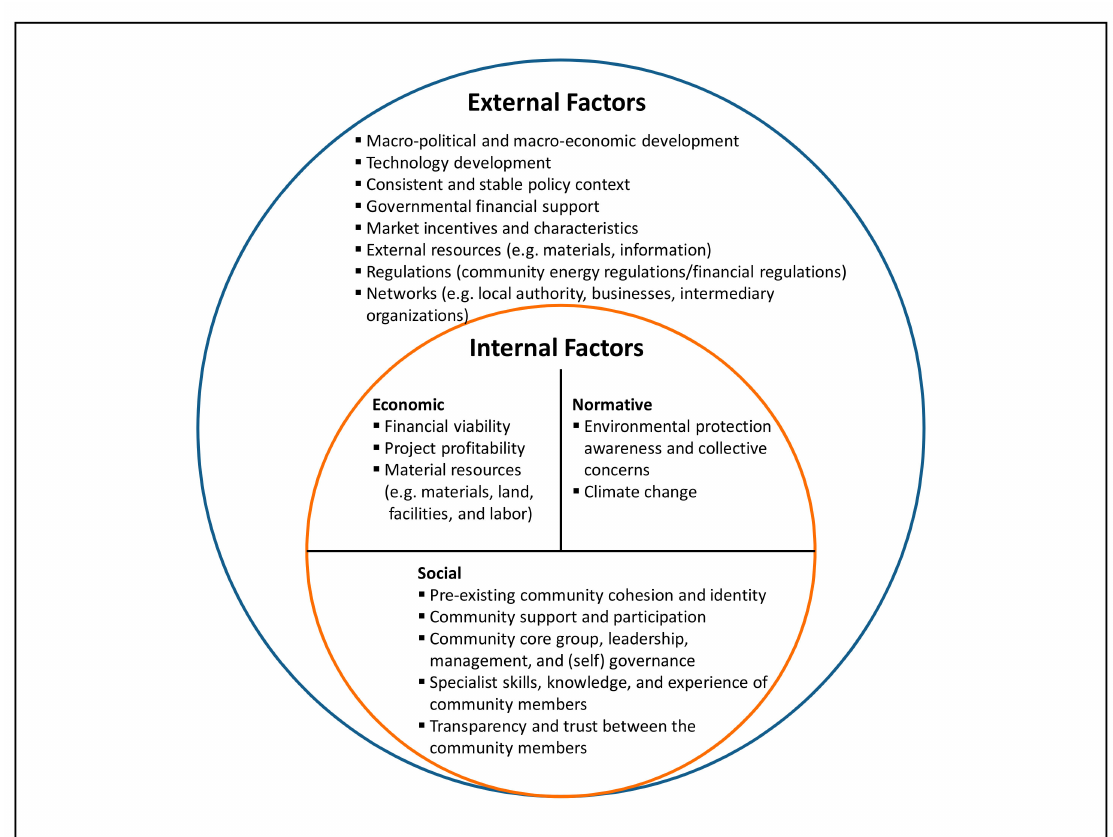
Figure 1. Success factors for community